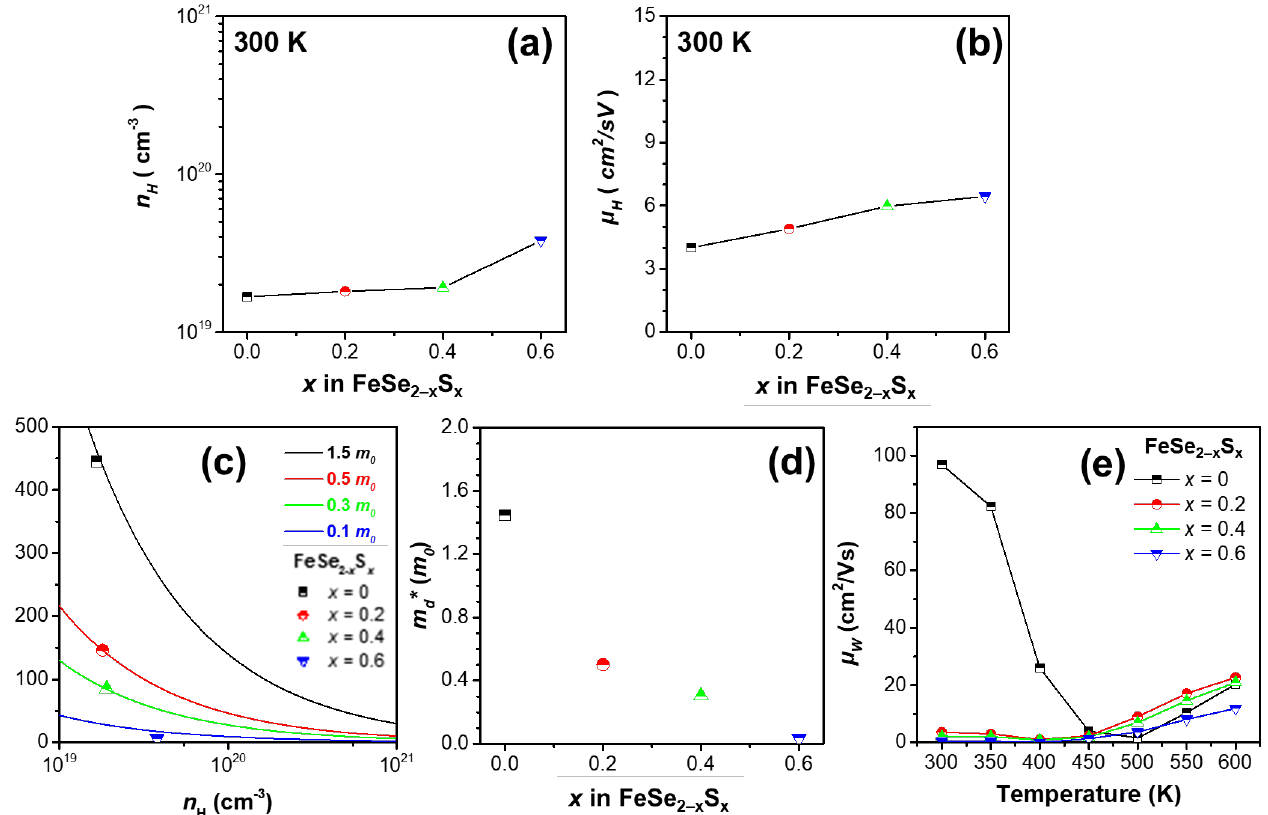
Figure 3. ( a ) n H and ( b ) μ H of the series of FeSe 2− x S x ( x = 0, 0.2, 0.4, and 0.6) samples. ( c ) S as a function of n H (Pisarenko plot) at 300 K. ( d ) m d* as a function of x in FeSe 2− x S x ( x = 0, 0.2, 0.4, and 0.6). ( e ) μ w as a function of temperature for the samples.